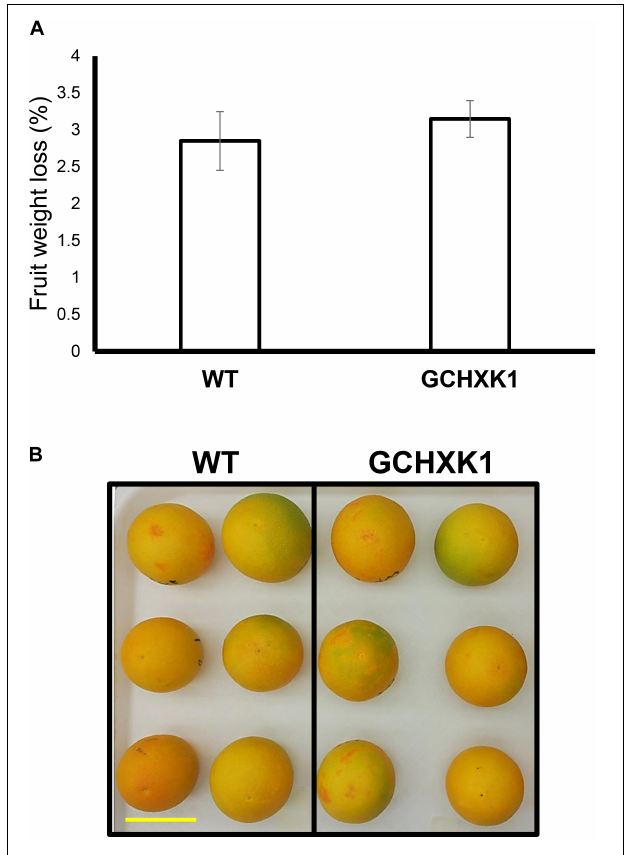
FIGURE 6 | Water loss of ripe GCHXK fruits. (A) Ripe, harvested WT, and GCHXK1 fruits exhibited similar water loss after 5 days of long-day conditions (16 h light/8 h dark photoperiod) at 25 ◦ C ( n = 6). (B) Ripe, harvested WT, and GCHXK1 fruits used for the water loss experiment, scale bar is 5 cm. Data displayed as means ±